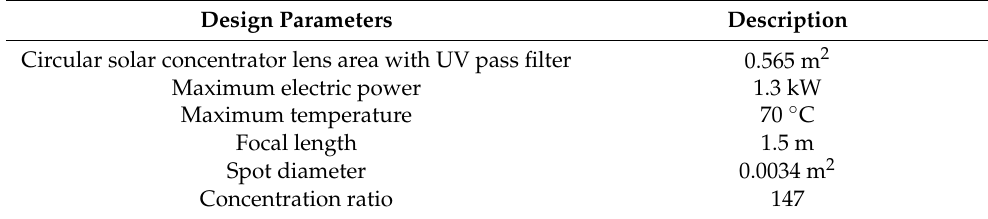
Figure 3. ( a ) An active Fresnel lens concentrating UVA and UVB (280 nm–400 nm) at PV panel by adjusting its focal point. When solar irradiance decreases, re-positioning of the lens takes place to adjust the spot size to keep the fixed value of solar interest. ( b ) Proposed desalinator structure with triple-axis Fresnel lens movement assembly for tracking the sun, filtering, and concentrating UVA and UVB (280 nm to 400 nm), and temperature adjustment to maintain 120 ◦ C inside the water tank. Table 1. Proposed design specifications of Fresnel lens concentrator for CPV